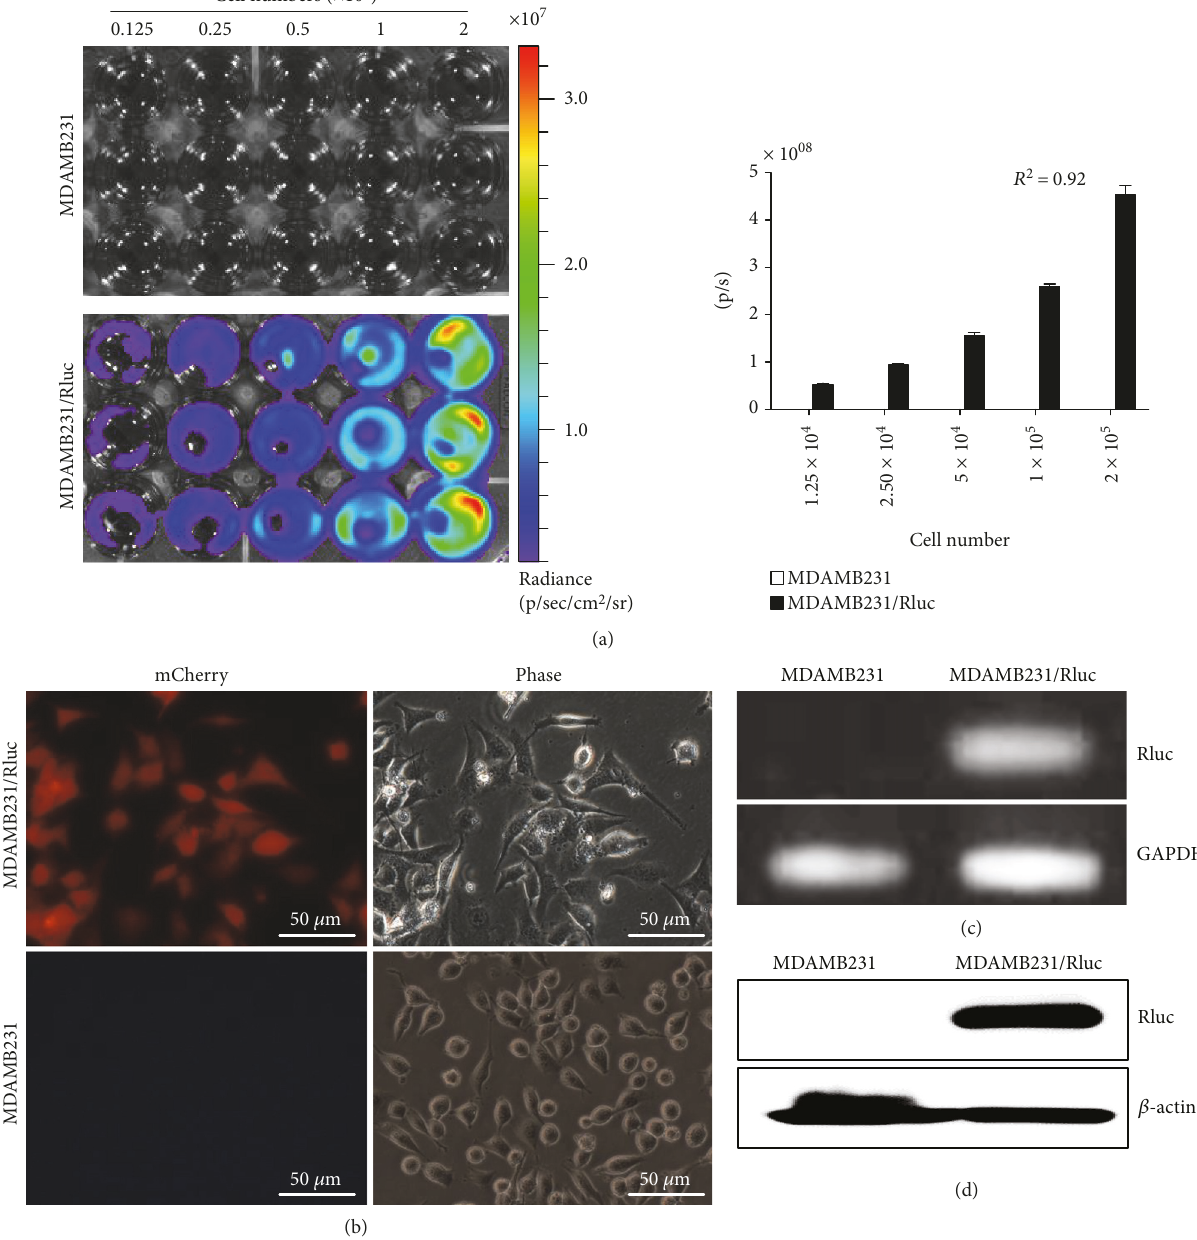
Figure 3: Characterization of MDAMB231/Rluc. (a) Rluc activity assessed by bioluminescent imaging (BLI) and quantitative analysis of MDAMB231/Rluc at di ff erent concentrations. (b) Transduced MDAMB231/Rluc cells were strongly positive for mCherry by fl uorescence microscopy. (c) Rluc mRNA expression by RT-PCR. (d) Rluc protein expression by Western